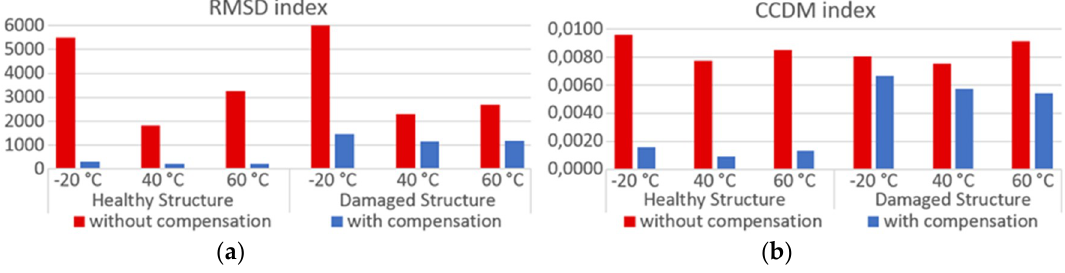
Figure 21. Damage index to assess the pipe-2/PZT-2 structural condition—Experiment: ( a ) without damage and ( b ) with damage.